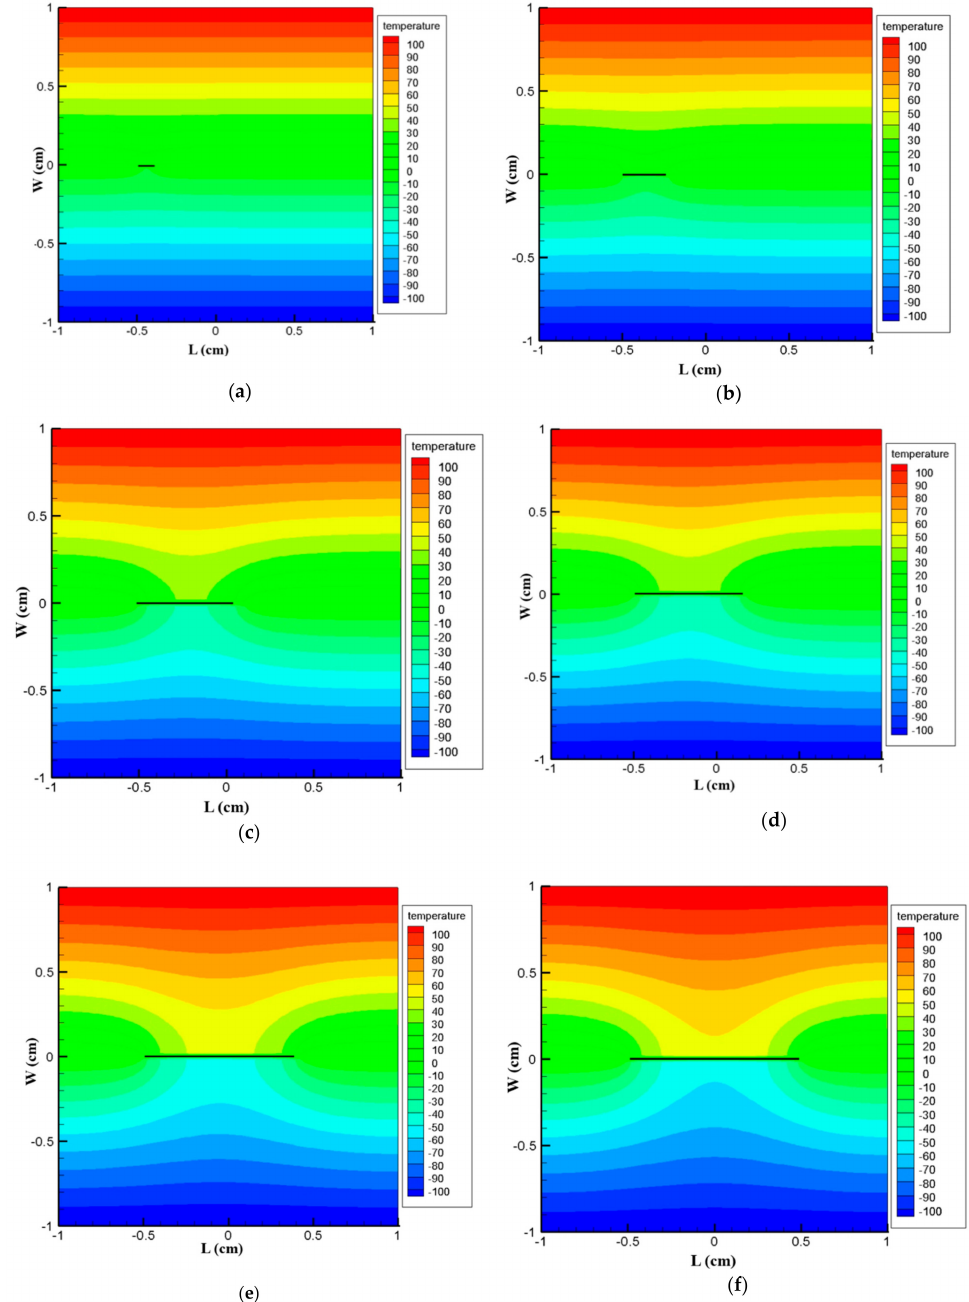
Figure 18. Temperature contour of plate with crack. ( a ) Temperature contour ( ◦ C) at t = 10 s; ( b ) Temperature contour ( ◦ C) at t = 20 s; ( c ) Temperature contour ( ◦ C) at t = 40 s; ( d )Temperature contour ( ◦ C) at t = 50 s; ( e ) Temperature contour ( ◦ C) at t = 60 s; ( f ) Temperature contour ( ◦ C) at t = 80